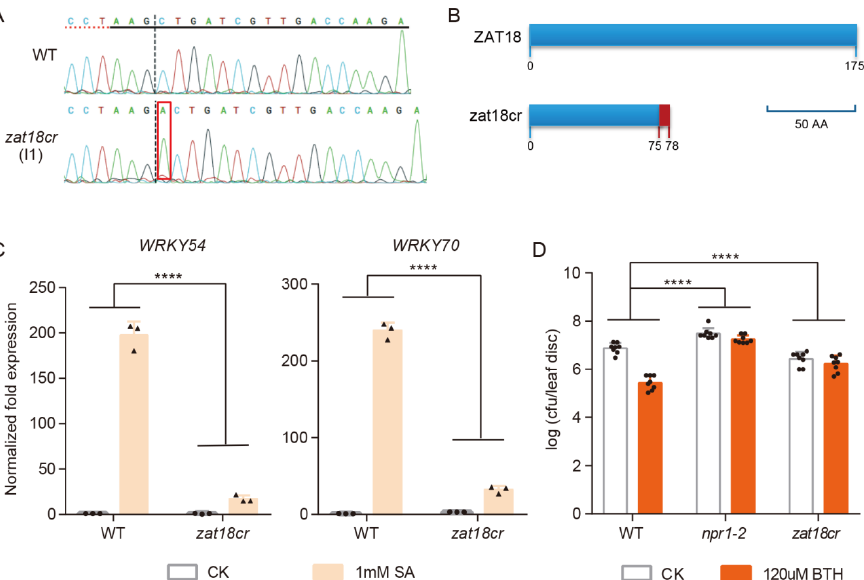
Figure 2. Generation of the zat18cr mutant and its SA-related phenotypes. ( A ) The Sanger sequencing chromatograms of WT and zat18cr are shown and the inserted A is marked. ( B ) The protein length encoded by ZAT18 in the WT and zat18cr . The light blue bar indicates the WT sequence of ZAT18 and the red bar represents the unmatched sequence. The bar graph of 50 AA represents the length of 50 amino acids (AAs) in the ZAT18 and zat18cr structures. ( C ) The expression levels of WRKY54 and WRKY70 in the WT and zat18cr mutant after sterile dH 2 O (CK) or 1 mM SA treatment for 1 h. Experiments were performed as described in Figure 1A. n = 3, n indicates the number of biological replicates. ( D ) BTH-induced resistance in the WT and zat18cr and npr1-2 mutants. Experiments were performed as described in Figure 1D. n = 8, n indicates the number of biological replicates.**** p < 0.0001.